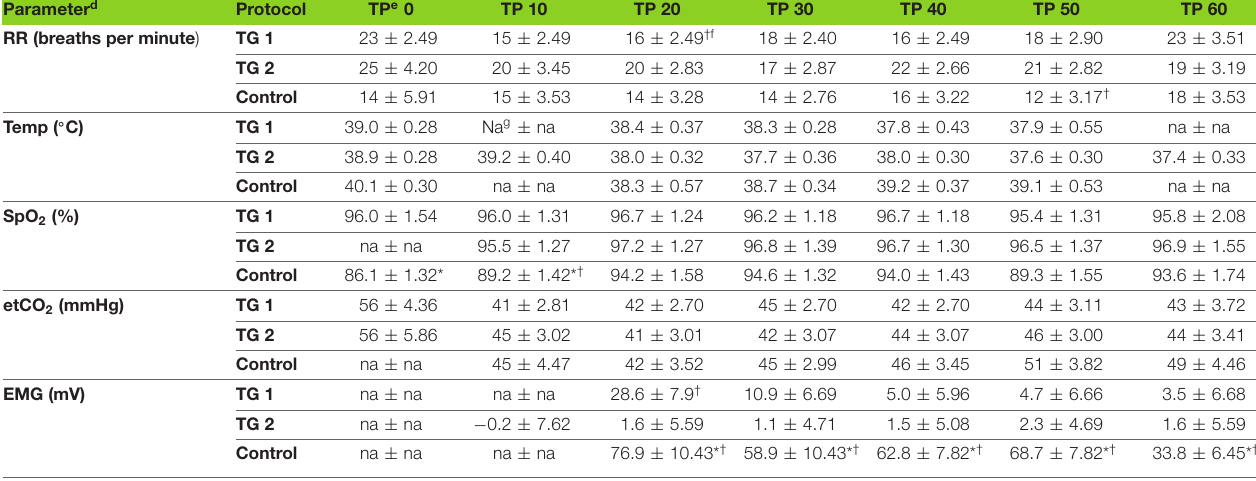
TABLE 5 | Vital parameters for TG a 1: ketamine–medetomidine–midazolam–butorphanol (KMMB), TG 2: tiletamine–zolazepam–medetomidine–butorphanol (TZMB), and CG b : etorphine–acepromazine–detomidine–butorphanol (EADB), immobilized kulans (Equus hemionus kulan) following recumbency at timepoint 0 for a 60-minute period. Parameter d